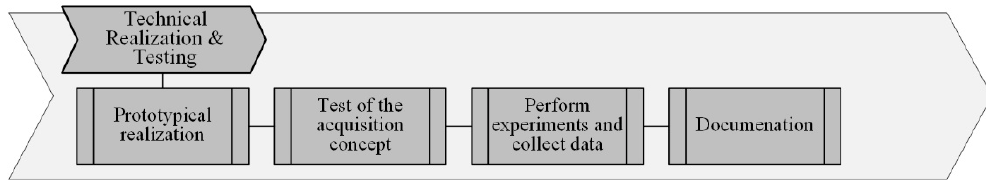
Figure 3. Tasks of the “Technical Realization & Testing” phase of the DMME reference model.